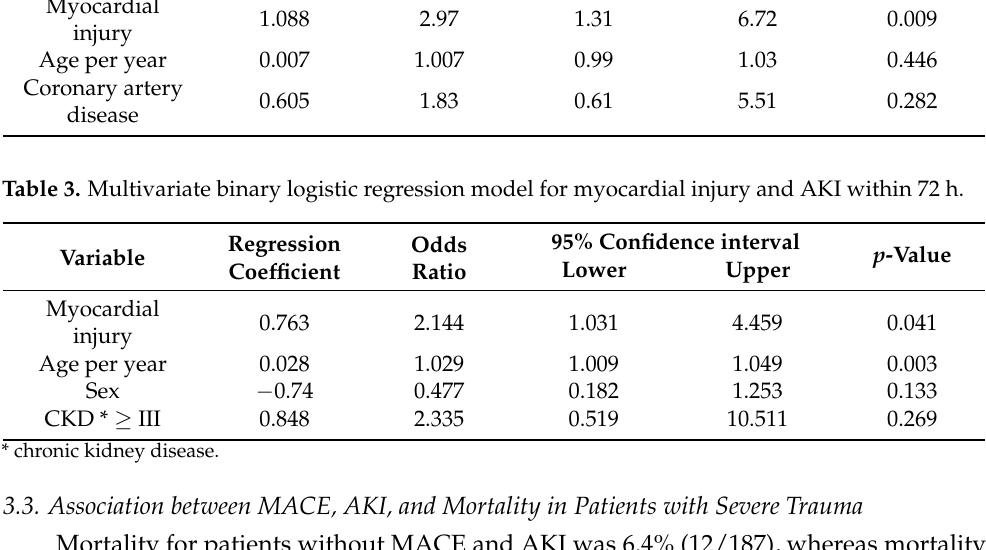
Table 2. Multivariate binary logistic regression model for myocardial injury and in-hospital MACE. Regression Variable